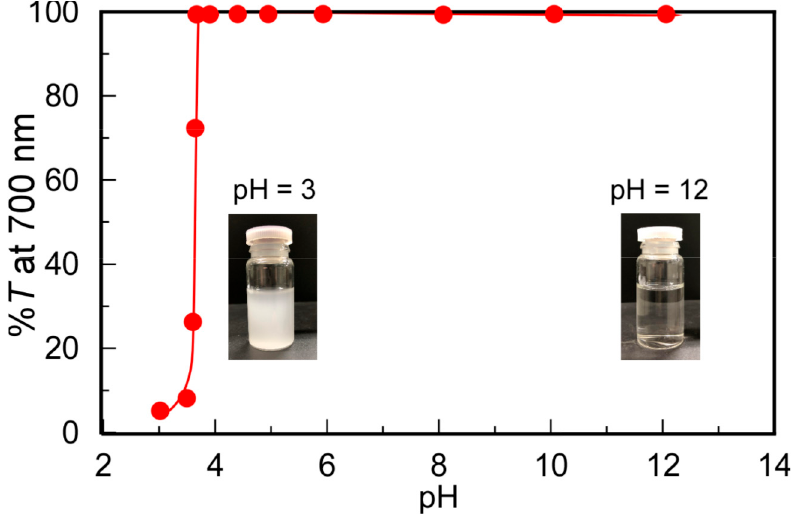
Figure 3. Percent transmittance (% T ) at 700 nm for PMPC/PAAc mixed aqueous solutions with f AAc = 0.85 as a function of pH at C p = 0.5 g/L, [NaCl] = 0.1 M, and 20 °C. Inserts are pictures of the PMPC/PAAc aqueous solutions at pH 3 and 12.